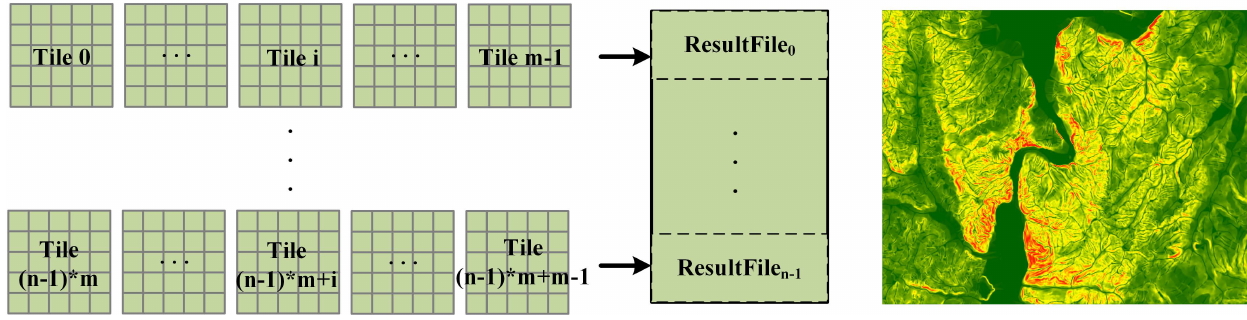
Figure 13. The data merging